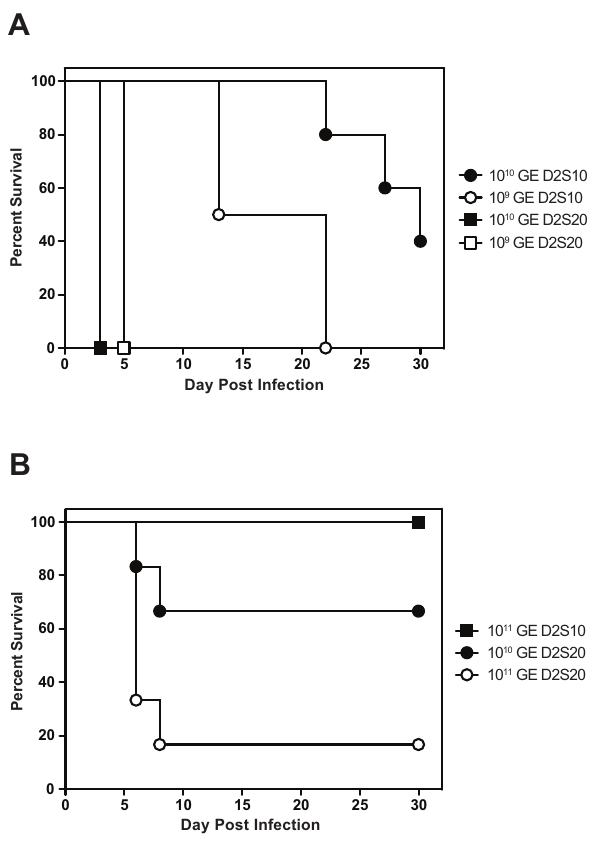
Figure 1. Survival of mice following infection with DENV. Survival was monitored for 30 days in 5–6 week old mice infected i.v. with DENV2 strain D2S10 or D2S20. (a) AG129 mice were inoculated with 10 9 or 10 10 GE (4–5 mice per group). Differences in survival between all groups were statistically significant (p , 0.005) except between groups infected with D2S10 (p=0.0139) using the log-rank test (4–5 mice per group). (b) IFNAR 2 / 2 mice were inoculated with 10 10 or 10 11 GE (6 mice per group). Statistically significant differences were observed between mice infected with 10 11 GE D2S10 and 10 11 GE D2S20 (p=0.0040).